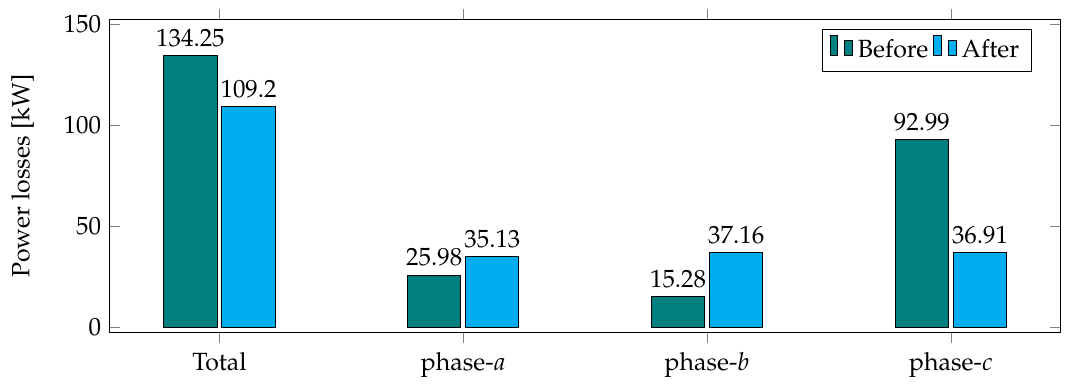
Figure 5. Effect of phase balancing on the amount of power loss in the 15-bus test feeder.